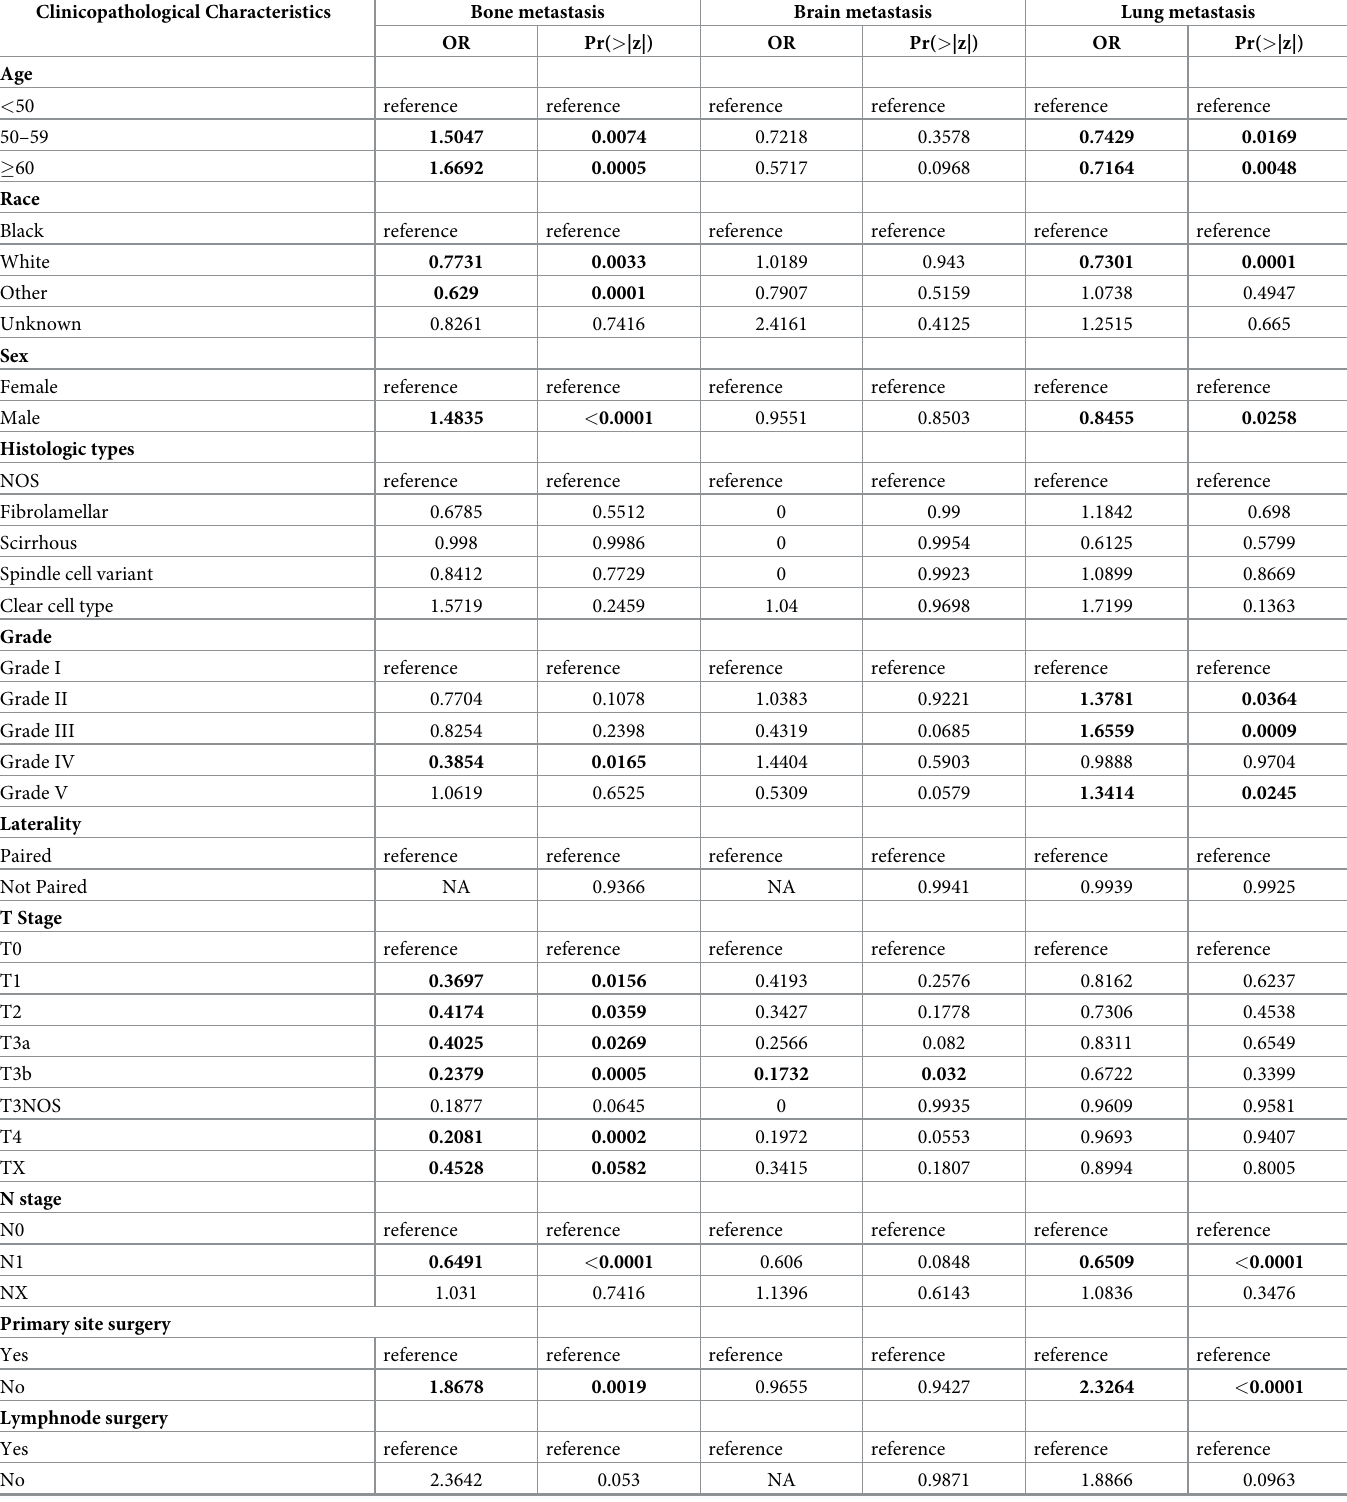
Table 3. Logistic regression of metastasis